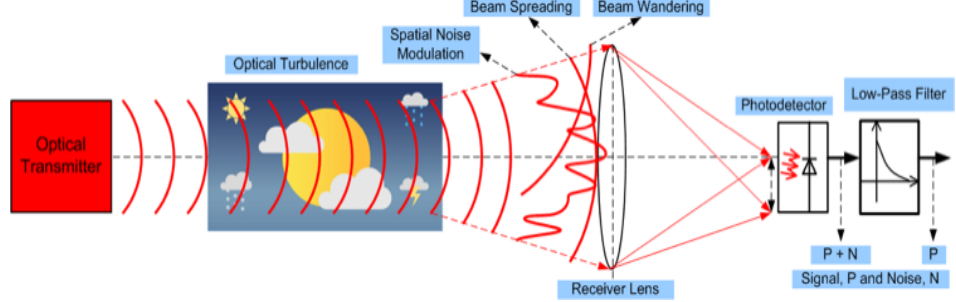
Figure 14. The low-pass filter in the output of the PD to minimize the output of noise caused by shot and thermal noise.